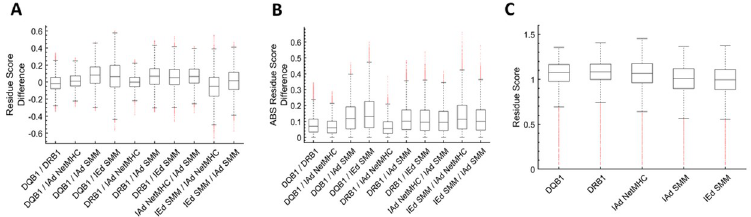
Fig 5. Comparing between prediction methods. (A) Direct comparison of differences in individual residue scores (when necessary, averaged over all isoforms within an isotype) between isotypes/methods in boxplot format (first indicated isotype/method minus second indicated isotype/method). (B) Comparison of the absolute value of the differences in individual residue scores (when necessary, averaged over all isoforms within an isotype) between isotypes/methods in boxplot format. (C) Comparison of residue scores of isotypes/methods in boxplot